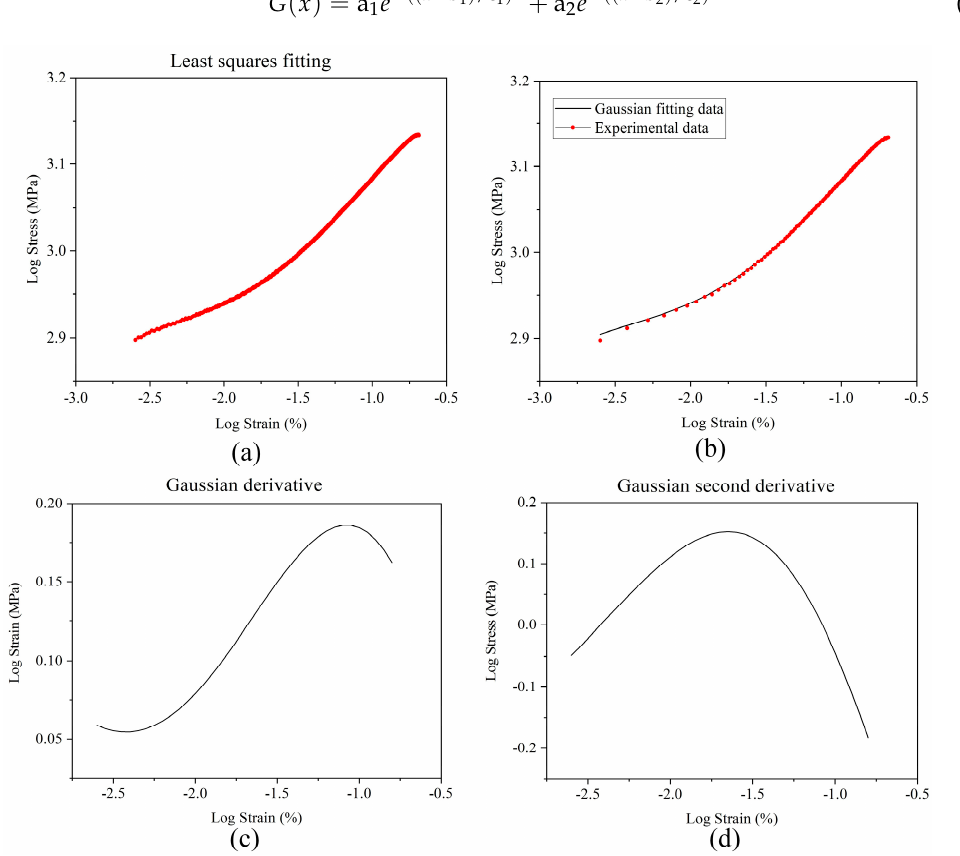
Figure 3. Fitting curve and extreme value analysis: ( a ) Least square fitting; ( b ) Gaussian fitting; ( c ) Gaussian derivative; ( d ) Gaussian second derivative.